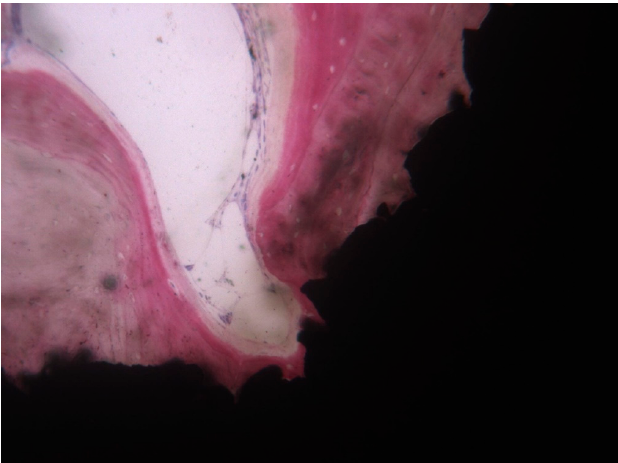
Figure 4. Compact, mature, and lamellar bone was in tight contact with the implant surface and adapted to all its microirregularities.Implant retrieved for esthetic reasons after 4 years loading time: The implant supported a bridge. Courtesy of Prof. Giovanna Iezzi and Prof. Adriano Piattelli (toluidine blue and acid fuchsin staining, magnification 100×).